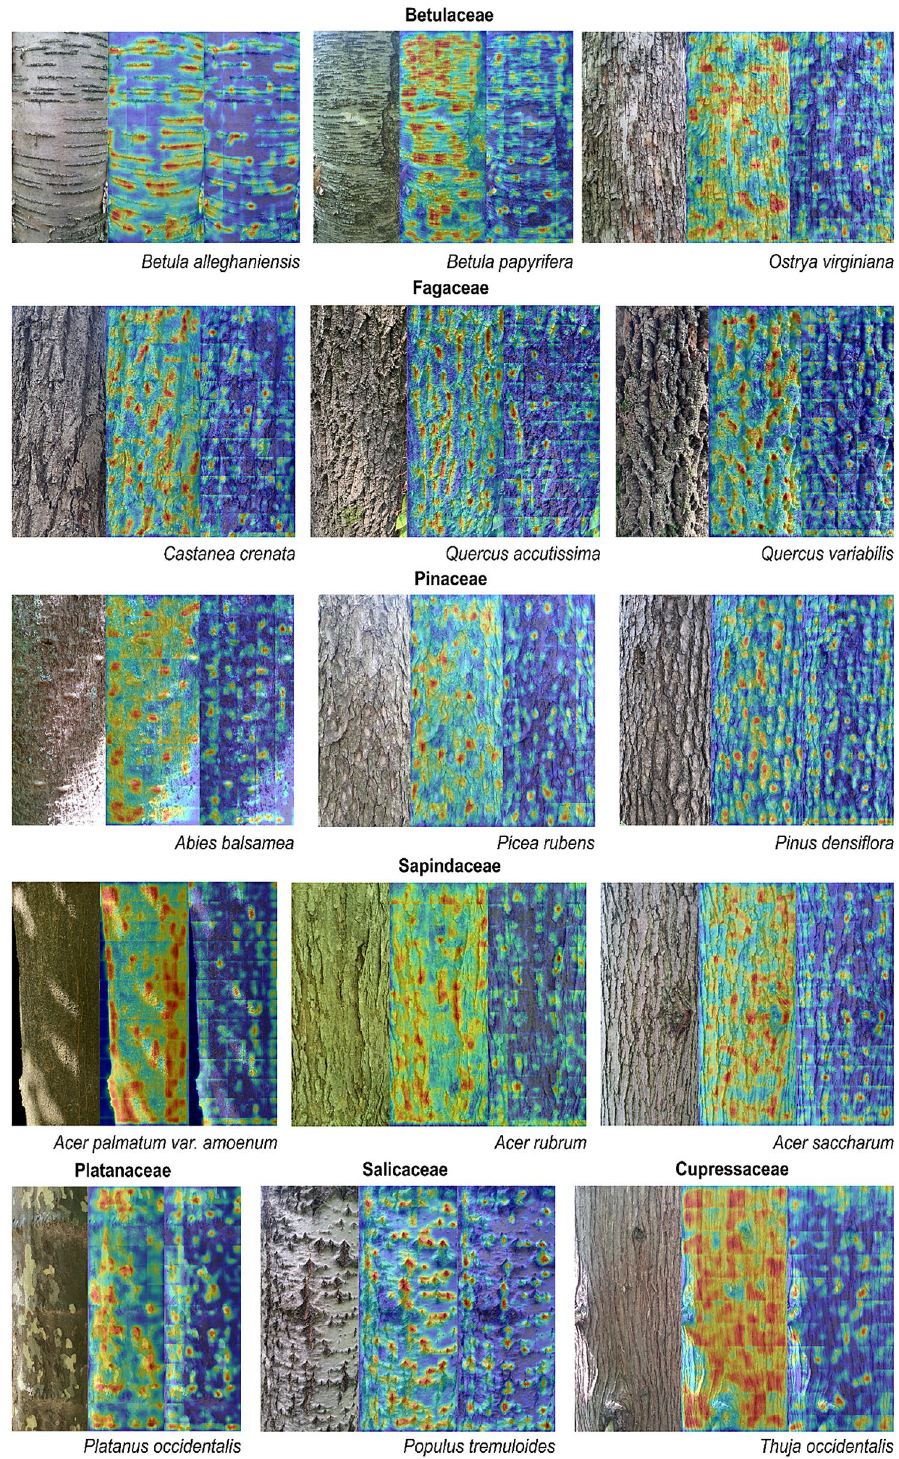
Figure 3. Representative CAM outputs from two CNN models; images on the left, middle, and right indicate the original image, CAM heatmap from VGG-16, and EfficientNet, respectively. Our proposed method, CAM aggregation (“Materials and methods”), enables to visualize unified representation of the diagnostic features over the entire bark. Regions highlighted in red denote the strongest activation from each model, which indicates the most relevant region for the prediction. CAM outputs of the entire 42 species are presented in the extended figures hosted on Figshare, https:// doi. org/ 10. 6084/ m9. figsh are. 14727